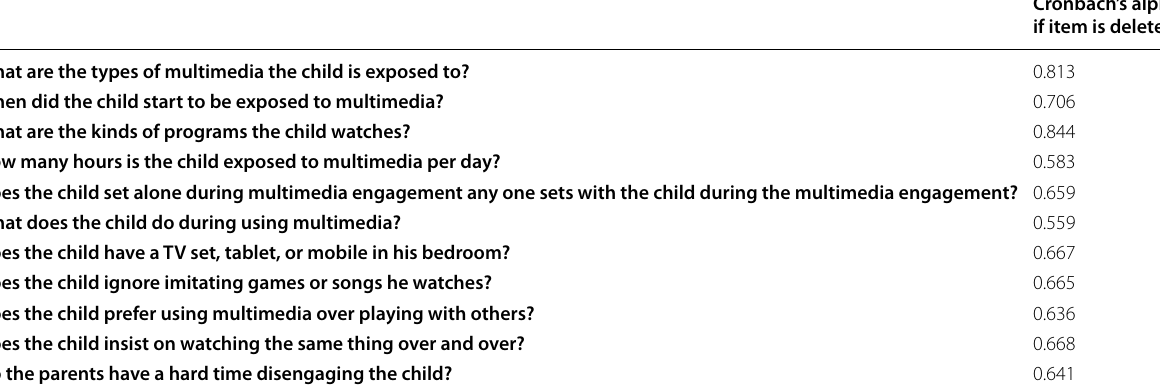
Table 9 Reliability assessment of used questions